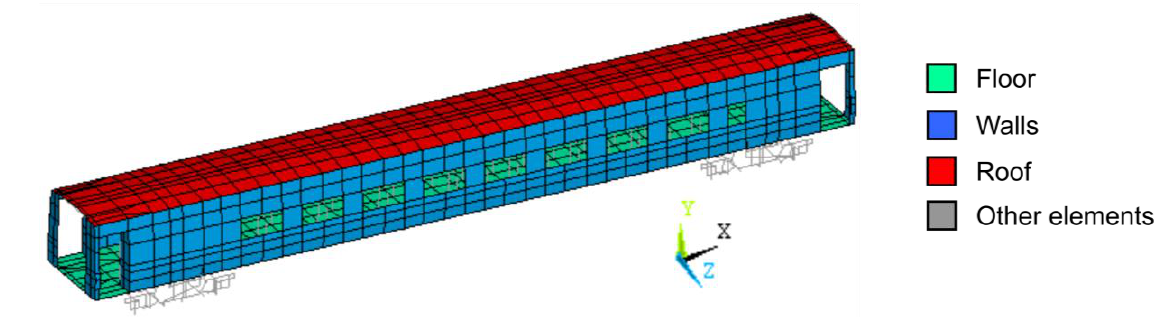
Figure 8. Identification of the clusters used in the numerical model of the BBN vehicle.